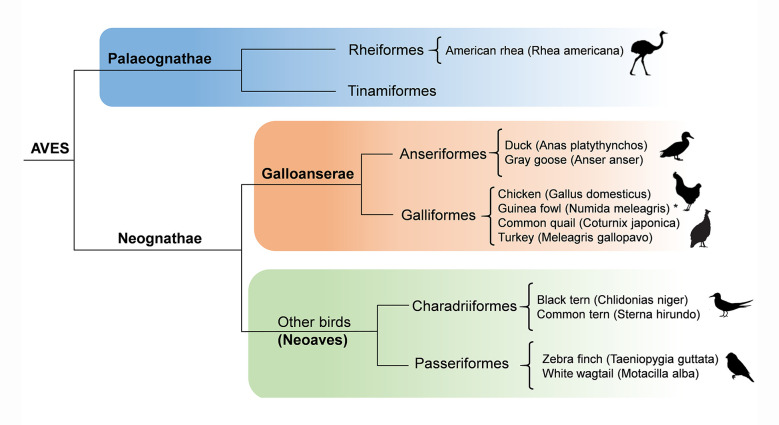
Simplified avian phylogenetic tree of avian groups with cytological crossover data.Except for Palaeognathae, the graph includes the avian orders with crossover data for at least two species. *Data for the guinea fowl are presented here. The tree is based on Prum et al., Nature 526(7574). doi: 10.1038/nature15697 (2017).